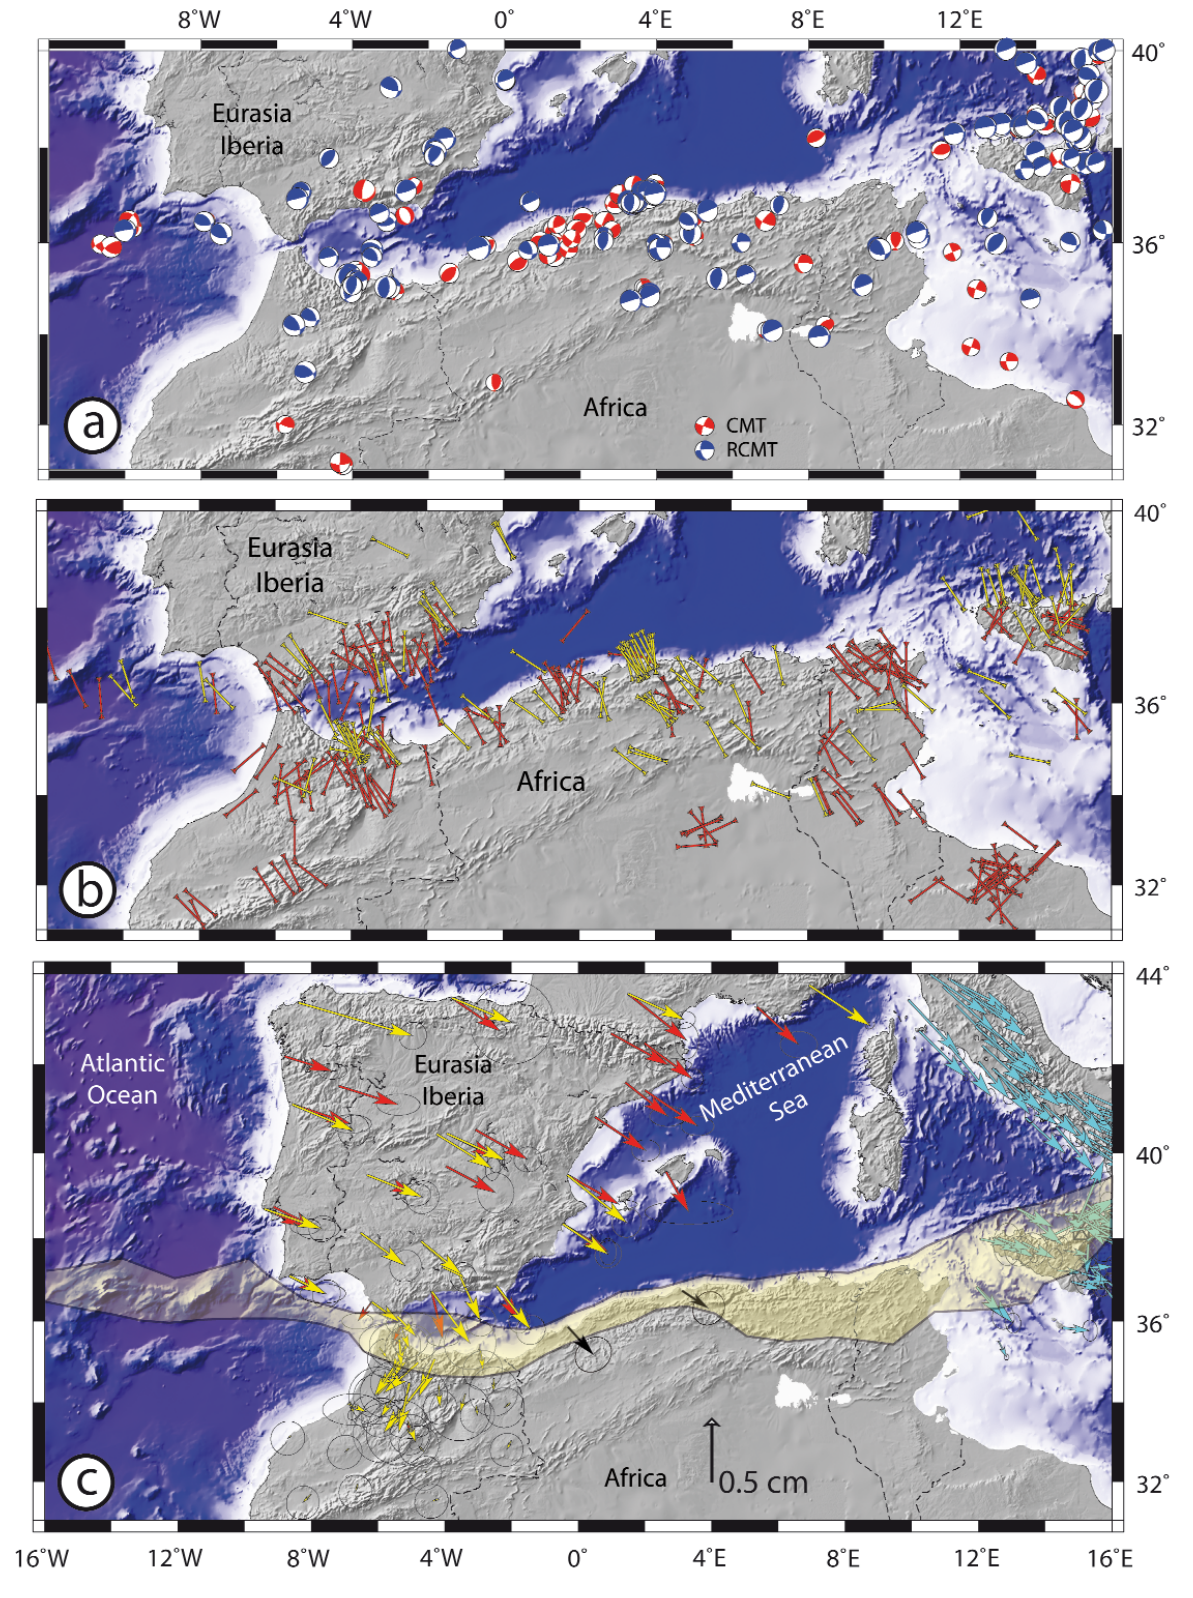
Figure 2. (a) Focal mechanism dataset used in the present study. Global CMTs in red and European Mediterranean RCMTs in blue (see main text for data references). (b) Quaternary tectonic shortening directions (red symbols) [Meghraoui 1988, Rebai et al. 1992, Morel and Meghraoui 1996] and P axes (yellow symbols) of all of the events mapped in Figure 2a for the dataset used in the present study. (c) Recent GPS data for the western Mediterranean with Nubia fixed (black, Anzidei et al. 2001; red, Fernandes et al. 2007; yellow, Vernant et al. 2010; cyan, Serpelloni et al. 2010). The yellow strip indicates the plate boundary zone in North Africa. A clockwise rotation of GPS directions can be observed from ENE-WSW in northern Iberia to NW-SE at the plate boundary in northern Algeria and N-S to ENE-SSW in northern Morocco. Note that the P axes and shortening directions of Figure 2b are not coincident with the convergence directions, as indicated by the GPS vectors in the western Mediterranean. This discrepancy is related to the obliquely convergent African and Eurasian